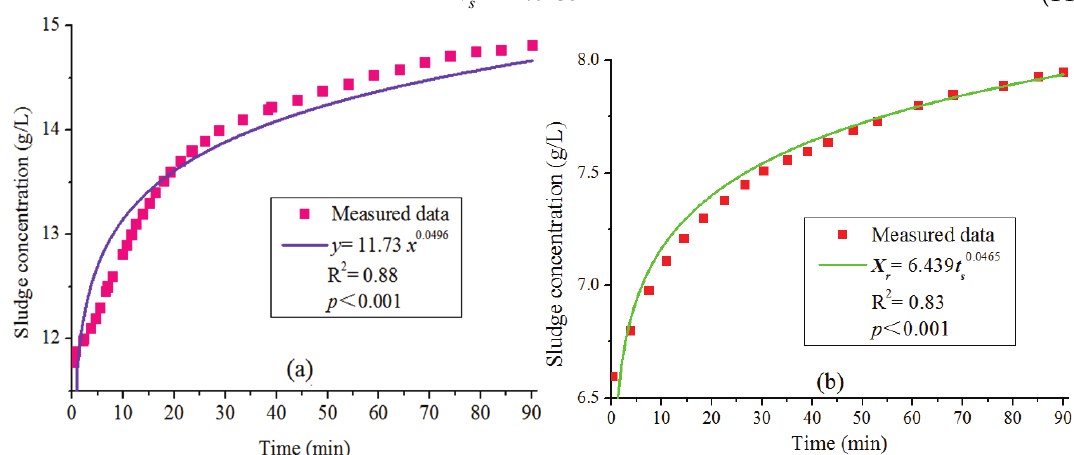
Figure 3. ( a ) The experimental data in wastewater treatment plant (WWTP) 1 of regression analysis applying the bottom sludge concentration model, ( b ) Proposed model validated with the measured data from wastewater treatment plant (WWTP) 5.